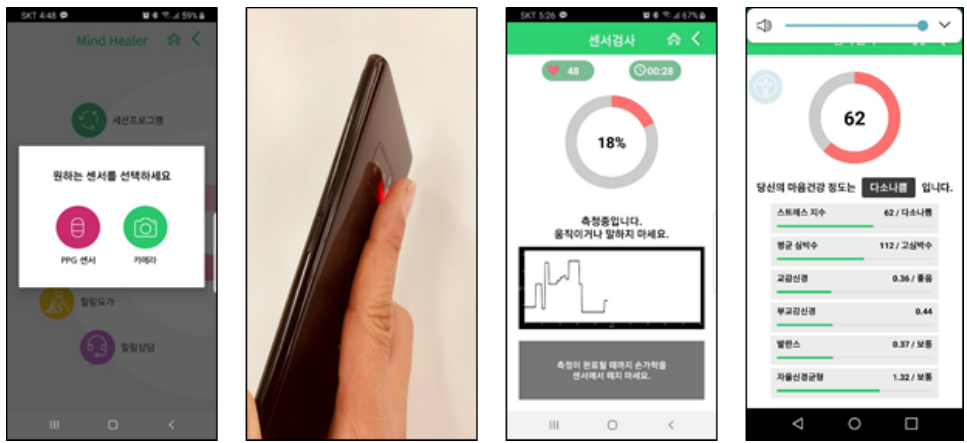
Figure 3. Photoplethysmogram (camera sensor for smartphones) sensor measurement and results. PPG and camera sensor option/Camera sensor apply/measurement/display of PPG.